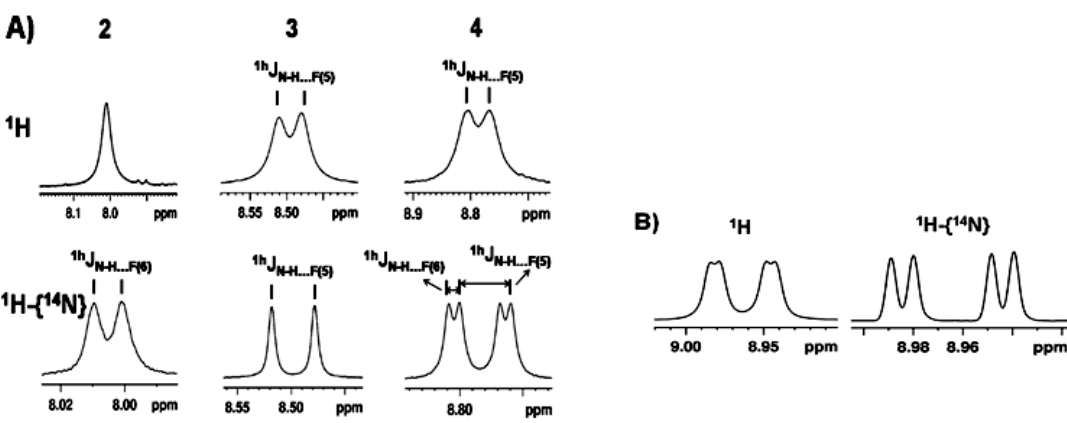
Figure 5. ( A ) The 1 H (left side) 1 H-{ 14 N} (right side) NMR spectrum of NH proton for the molecules 2 , 3 and 4 respectively at 298 K. ( B ) The 1 H and 1 H-{ 14 N} NMR spectrum of NH proton for molecule 4 at 230 K.